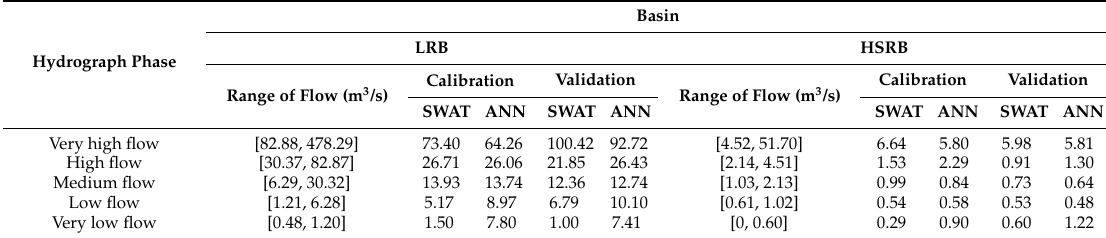
Table 10. RMSE values (m 3 /s) of SWAT and ANN models in each hydrograph